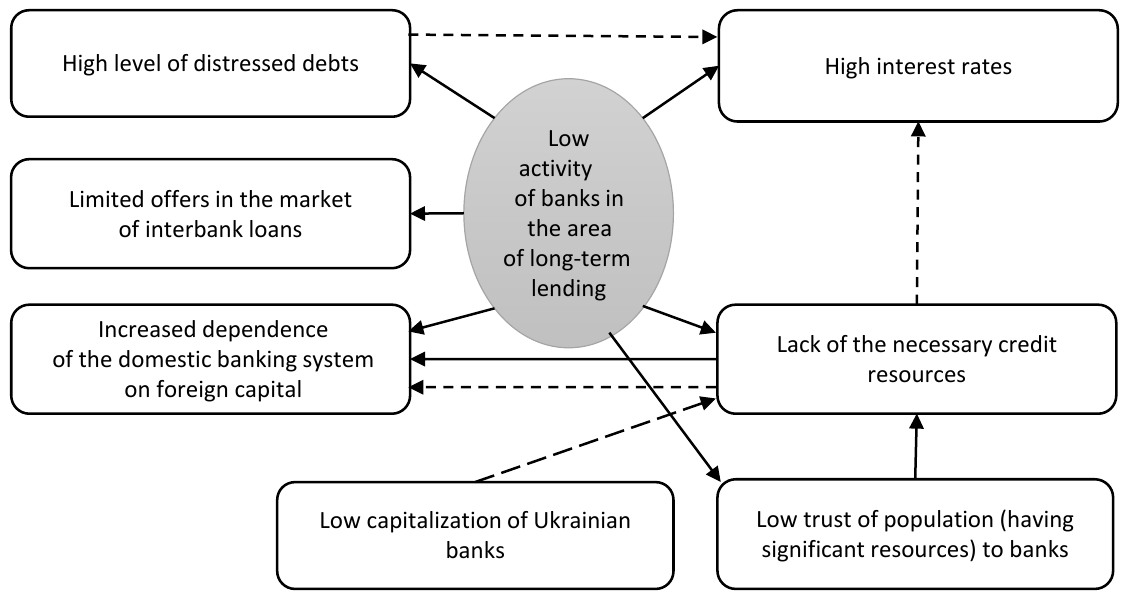
Figure 2. The main reasons for the low activity of Ukrainian banks in the market of long-term lending to economic entities of the